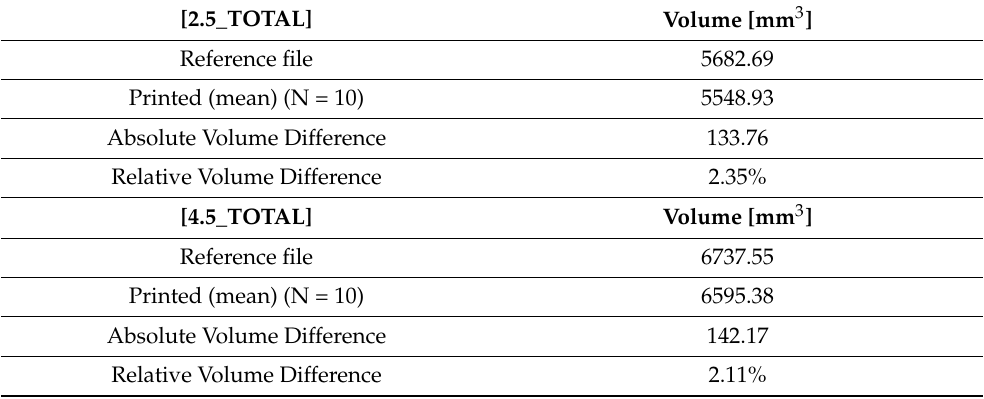
Table 6. Absolute and relative volume differences between reference and